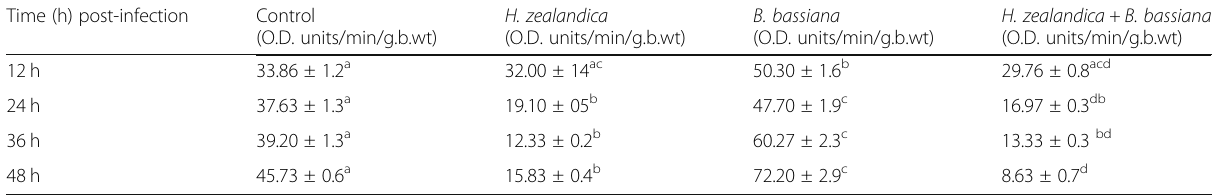
Table 3 Changes in phenoloxidase activity (mean ± SE) of last instar Galleria mellonella larvae at 12, 24, 36, and 48 h post-infection with Heterorhabditis zealandica , Beauveria bassiana , and their combination Time (h) post-infection Control (O.D.